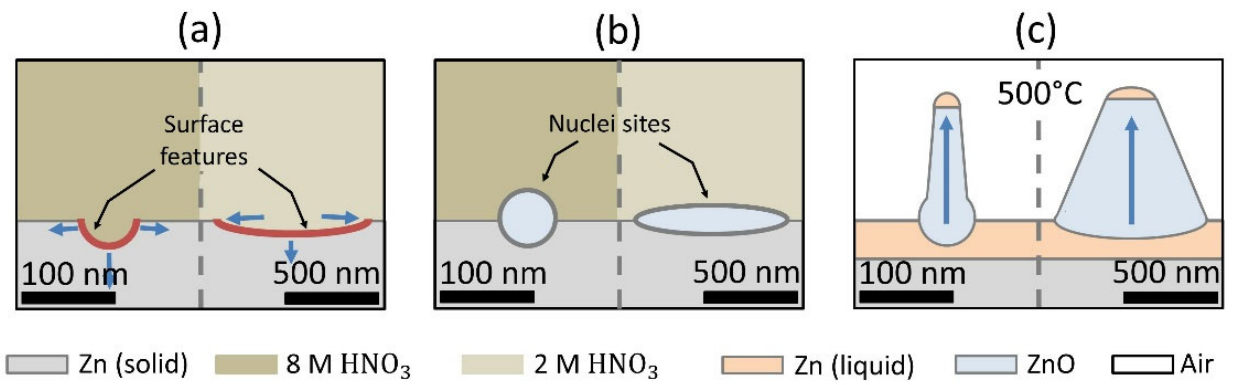
Figure 4. Schematic representation for the growth path of nanostructured ZnO arrays: ( a ) the pattern on Zn foil promoted by the acid etching process, ( b ) the phase transition given by the nucleation mechanism, and ( c ) growth of nanostructured ZnO arrays by the solid–liquid mechanism on nucle ‐